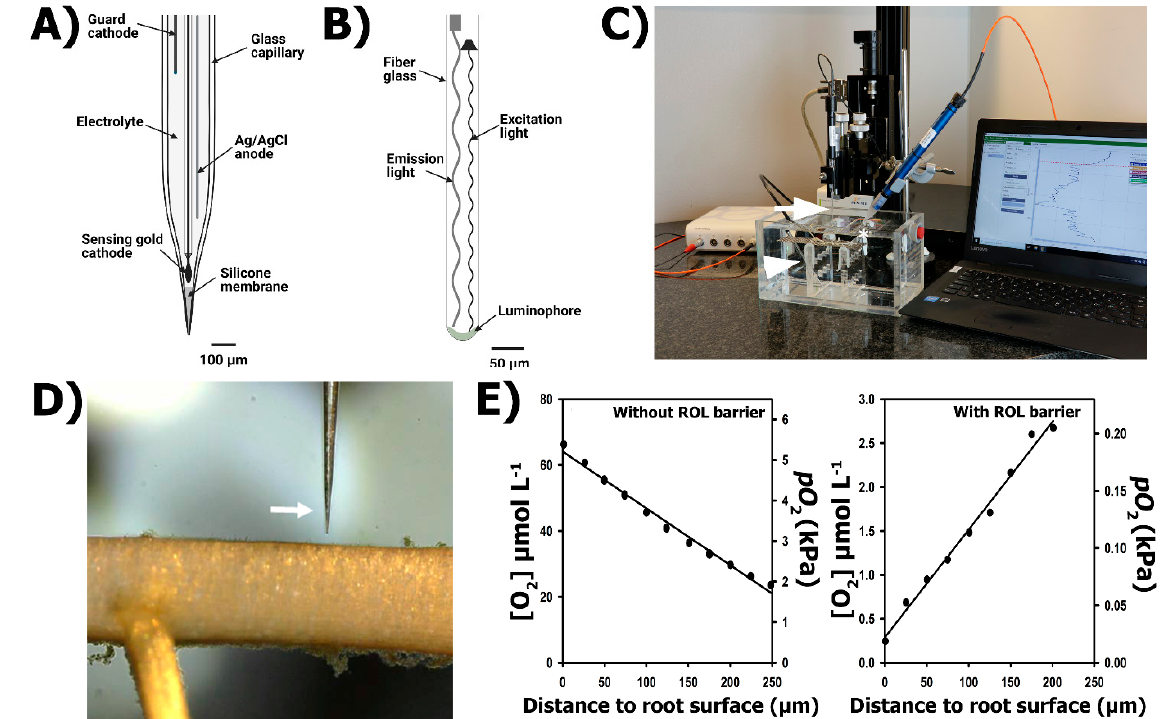
Figure 4. O 2 microelectrodes and O 2 micro-optodes for ROL determination from roots. ( A ) Clark-type O 2 microelectrode with guard cathode. ( B ) O 2 micro-optode. ( C ) General set-up including a transparent acrylic chamber filled with deoxygenated solution and the submerged roots (detached) of a rice plant. The O 2 microelectrode (to obtain spatial concentration profiles) and the O 2 micro-optode (to follow the O 2 in the bulk) are mounted in a motorized stage and connected to a picoammeter and an optode meter, respectively. ( D ) Close-up of an O 2 microelectrode near the root surface of Zea nicaraguensis . ( E ) Characteristic O 2 gradients from roots without a barrier (roots from Zea nicaraguensis plants grown in aerated nutrient solutions for 25 days, left) and a tight barrier to ROL (roots from Zea nicaraguensis plants grown in staganant, deoxygenated nutrient solutions for 25 days, right). Arrow in C points to O 2 microelectrode, arrowhead to temperature sensor and asterisk key to O 2 micro ‐ optode. Arrow in D shows the tip of an O 2 microelectrode.